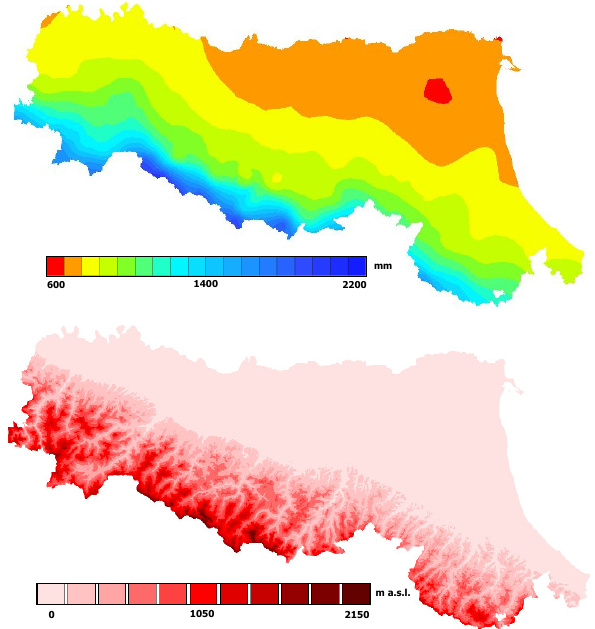
Fig. 1. Mean annual precipitation (“Precipitazioni annue – Periodo 1991–2008”, ARPA Regione Emilia Romagna) and digital elevation model of the Emilia-Romagna